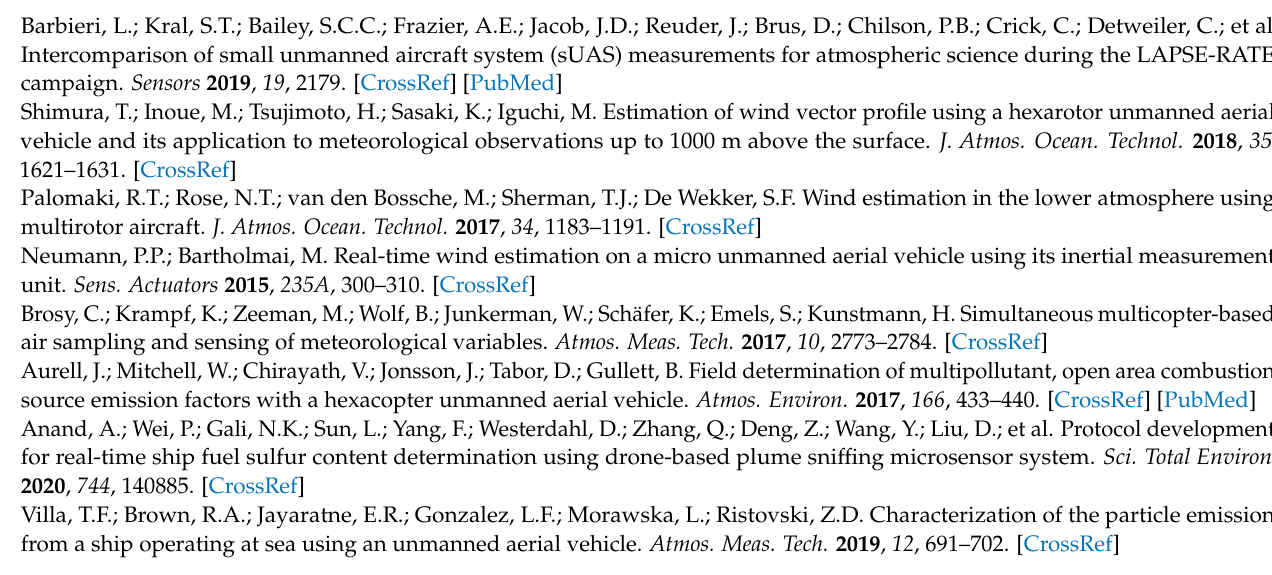
Figure S2: Particle concentrations observed by disdrometers deployed Sakurajima on 26–27